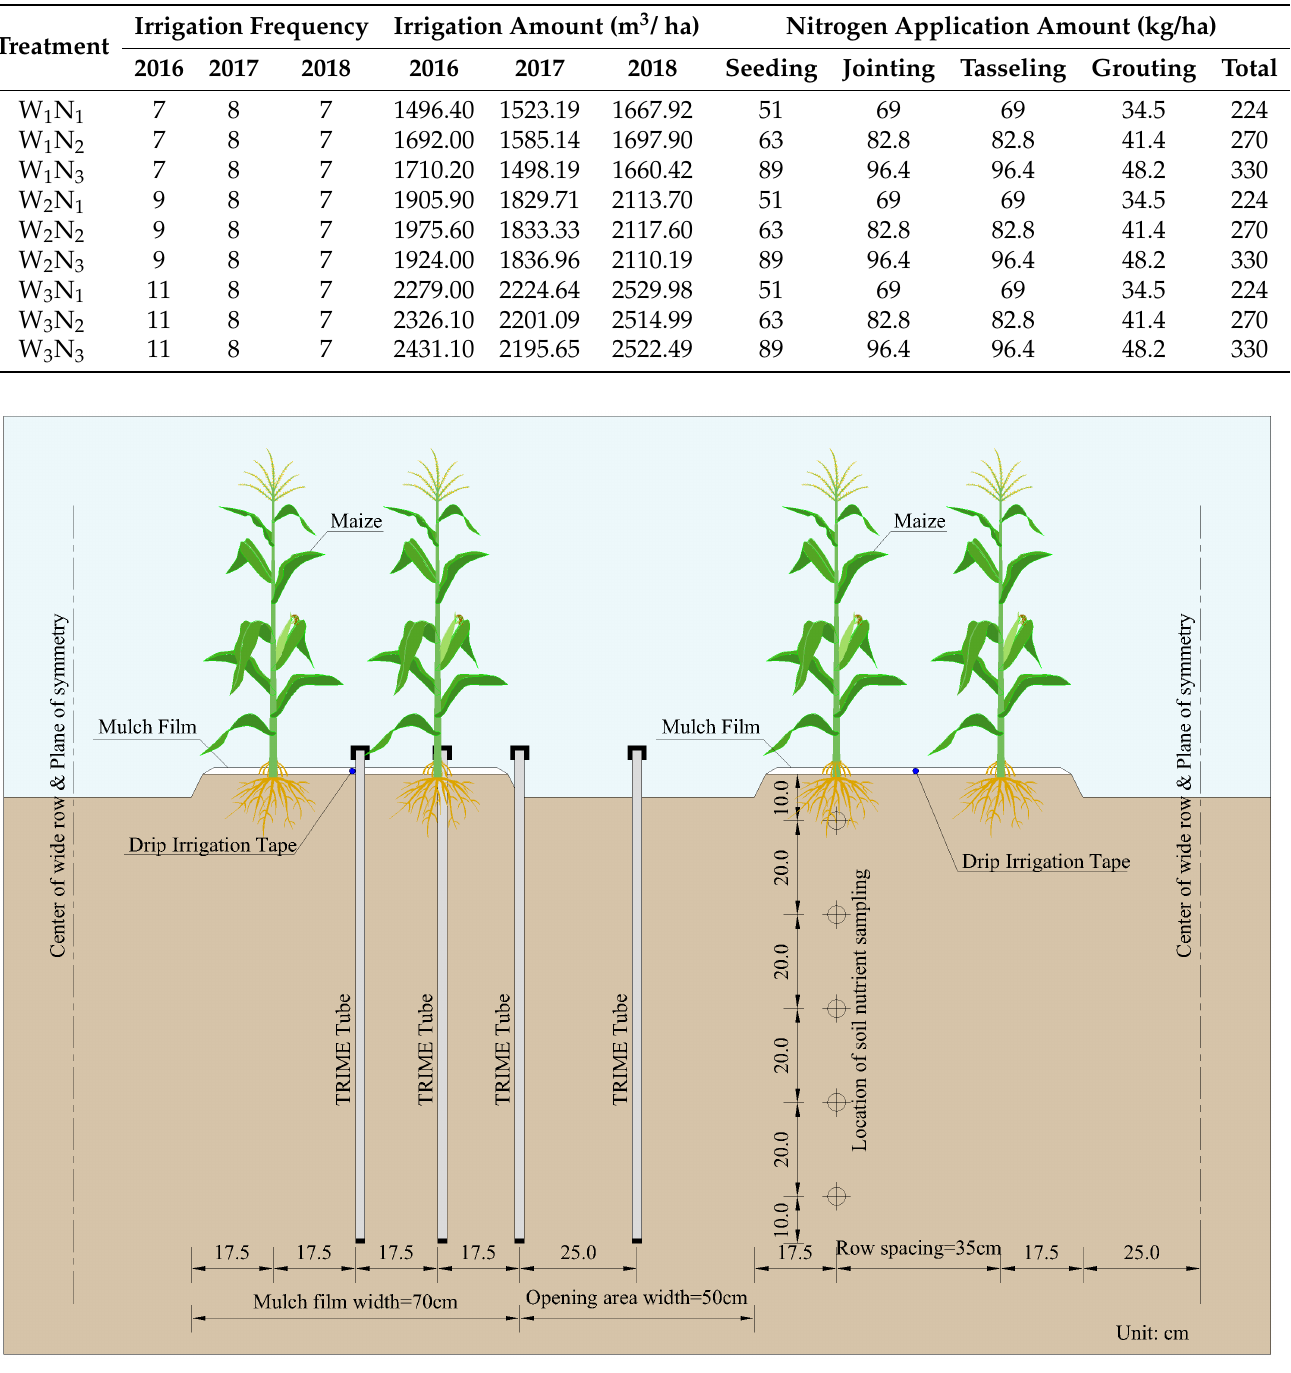
Figure 1. Schematic diagram of planting mode and sampling monitoring of soil moisture